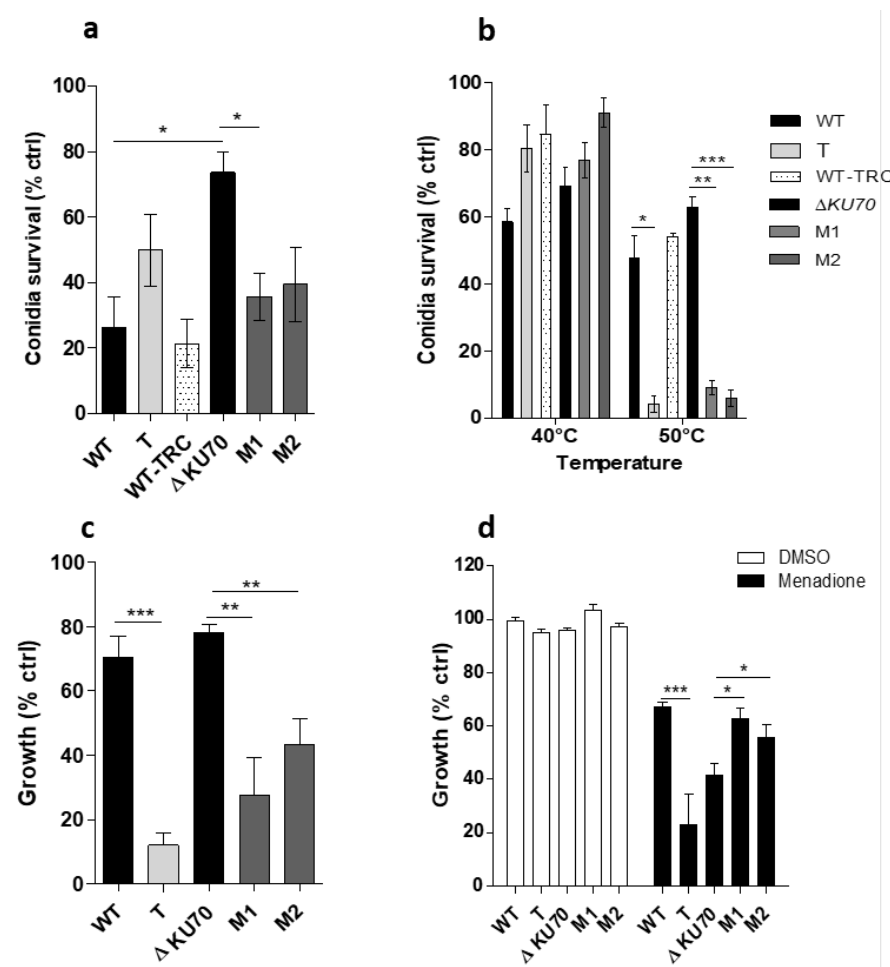
Figure 8. Susceptibility of the T and the M1 and M2 deleted strains exposed to exogenous stresses. ( a ) Conidia survival after exposure to UV-C light. After exposure to a dose of 30 mJ/cm 2 at 254 nm, conidia were stained with 25 µ M propidium iodide (PI) before being analyzed on a LSRFortessa TM cytometer. The graph presents the percentage survival among exposed FITC + conidia expressed relative to that of unexposed FITC + conidia (live control), as follows: 100 × ((% PI − FITC + conidia among unexposed control conidia—% PI − FITC + conidia among exposed conidia)/(% PI − FITC + conidia among unexposed control conidia)). ( b ) Conidia survival after exposure to high temperature. After incubation at 40 ◦ C or 50 ◦ C for 15 min, 200 conidia were incubated on PDA plates at 37 ◦ C for 72 h. The number of colonies reflect the number of live conidia. The graph presents the ratio between the number of colonies recovered after exposure of the conidia to heat and the number of colonies recovered after no heat exposure on PDA plates. ( c , d ) Growth under oxidative conditions. Mycelial growth in PDB medium supplemented with 200 µ M cumene hydroperoxide ( c ) or 40 µ M menadione ( d ) was monitored when incubated for 40 h at 37 ◦ C by nephelometry. Results are expressed in relative nephelometric units resulting from the measurement of the intensity of scattered light through the wall as an indication of the increasing turbidity due to the mycelia. DMSO was used to dissolve the menadione powder. Graphs present the relative growth calculated as the ratio between the nephelometric signal obtained in the presence of an oxidizing compound and in oxidant-free PDB (growth control). All graphs include results obtained from three independent experiments: * p < 0.05, ** p < 0.01, *** p < 0.001 (Kruskall-Wallis test). T: transformant derived from the WT strain; M1 and M2: transformants derived from the Δ KU70 strain.